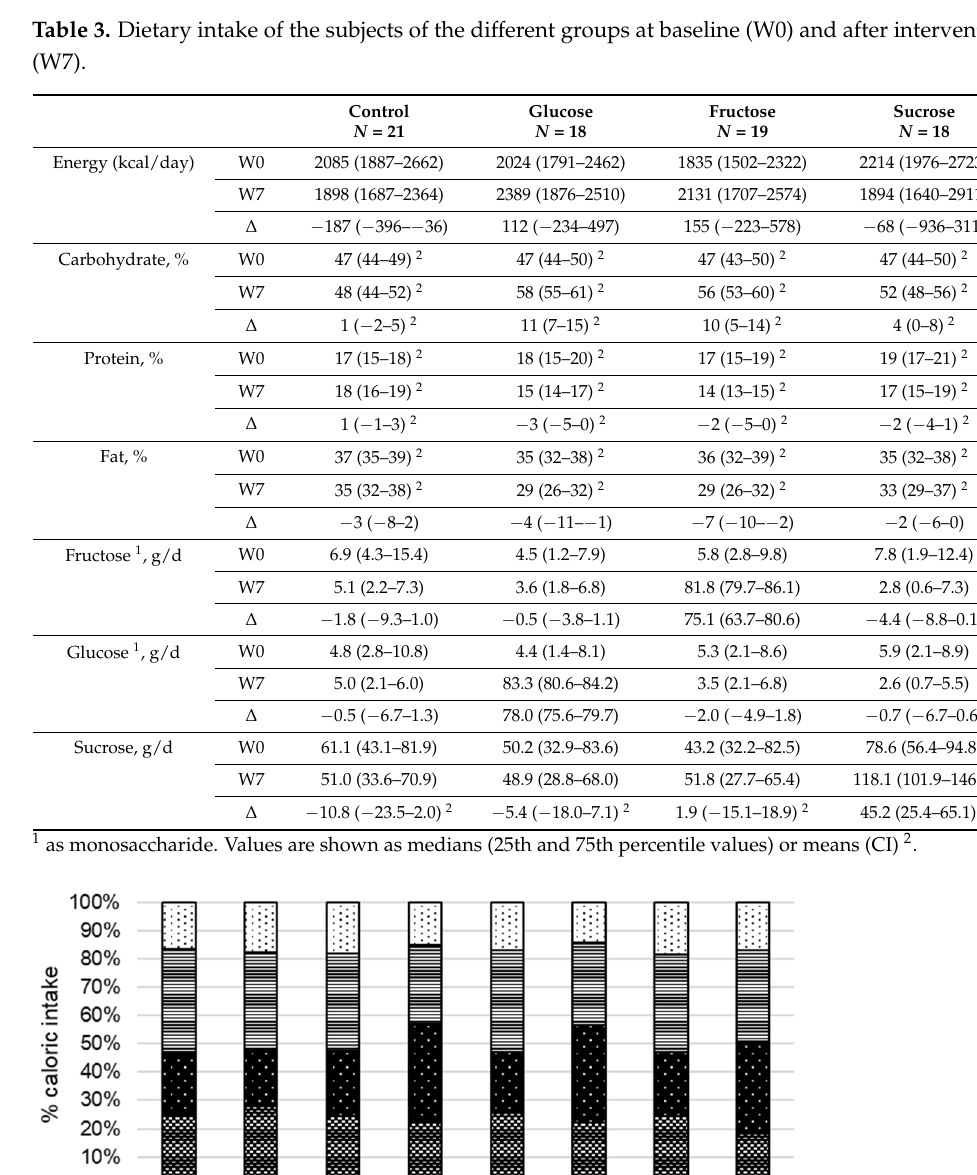
Table 3. Dietary intake of the subjects of the different groups at baseline (W0) and after intervention (W7).